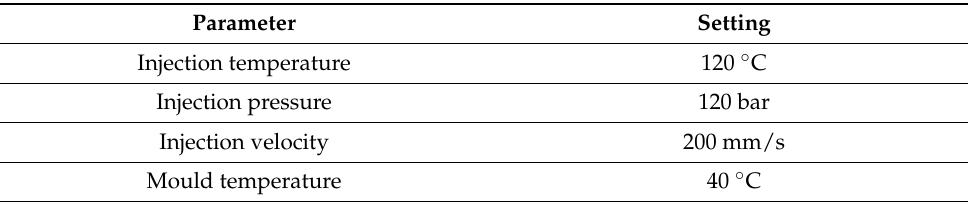
Table 3. Moulding